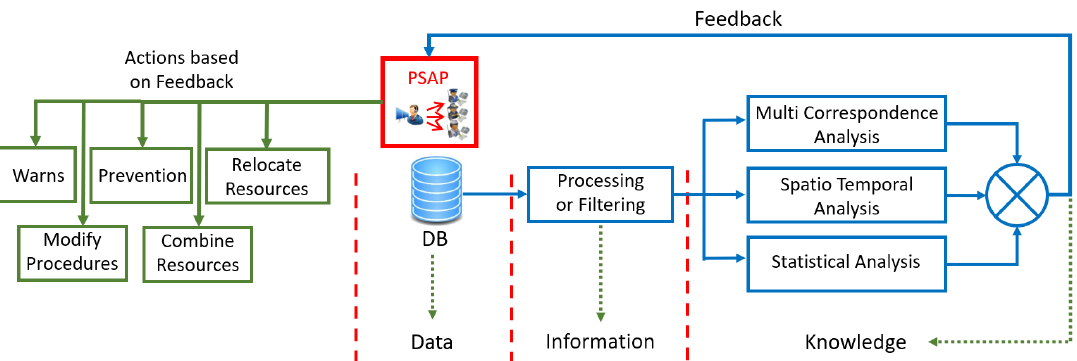
Figure 11. If the data saved in the DB are processed, they become information, and by applying different types of analysis it can be transformed into knowledge to give feedback to the management, so that the PSAP can take actions oriented to warn the users, to prevent accidents, or to improve the response in case of emergency.